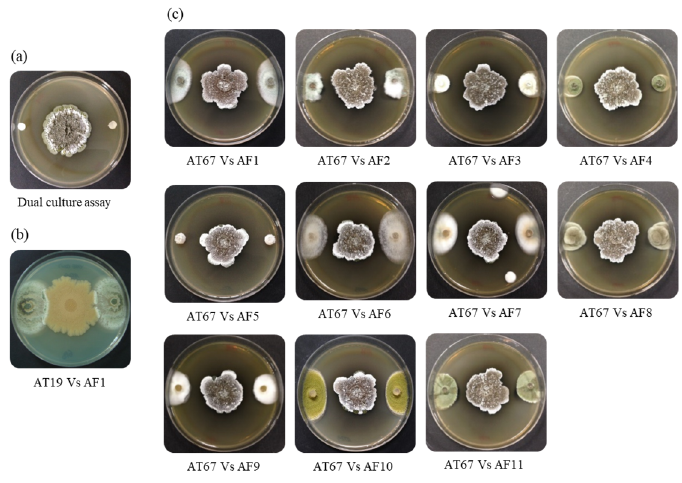
Figure 1. Dual culture antifungal assays with Actinobacteria isolated from dung beetles ( Copris tripartitus ) or their dung balls. ( a ) The experimental figure of the dual culture assay, ( b ) Representative result of bacterial isolate with no antifungal activity (e.g., AT19 vs. AF1), ( c ) Antifungal activity of strain AT67 against 11 fungi (AF1–AF11).